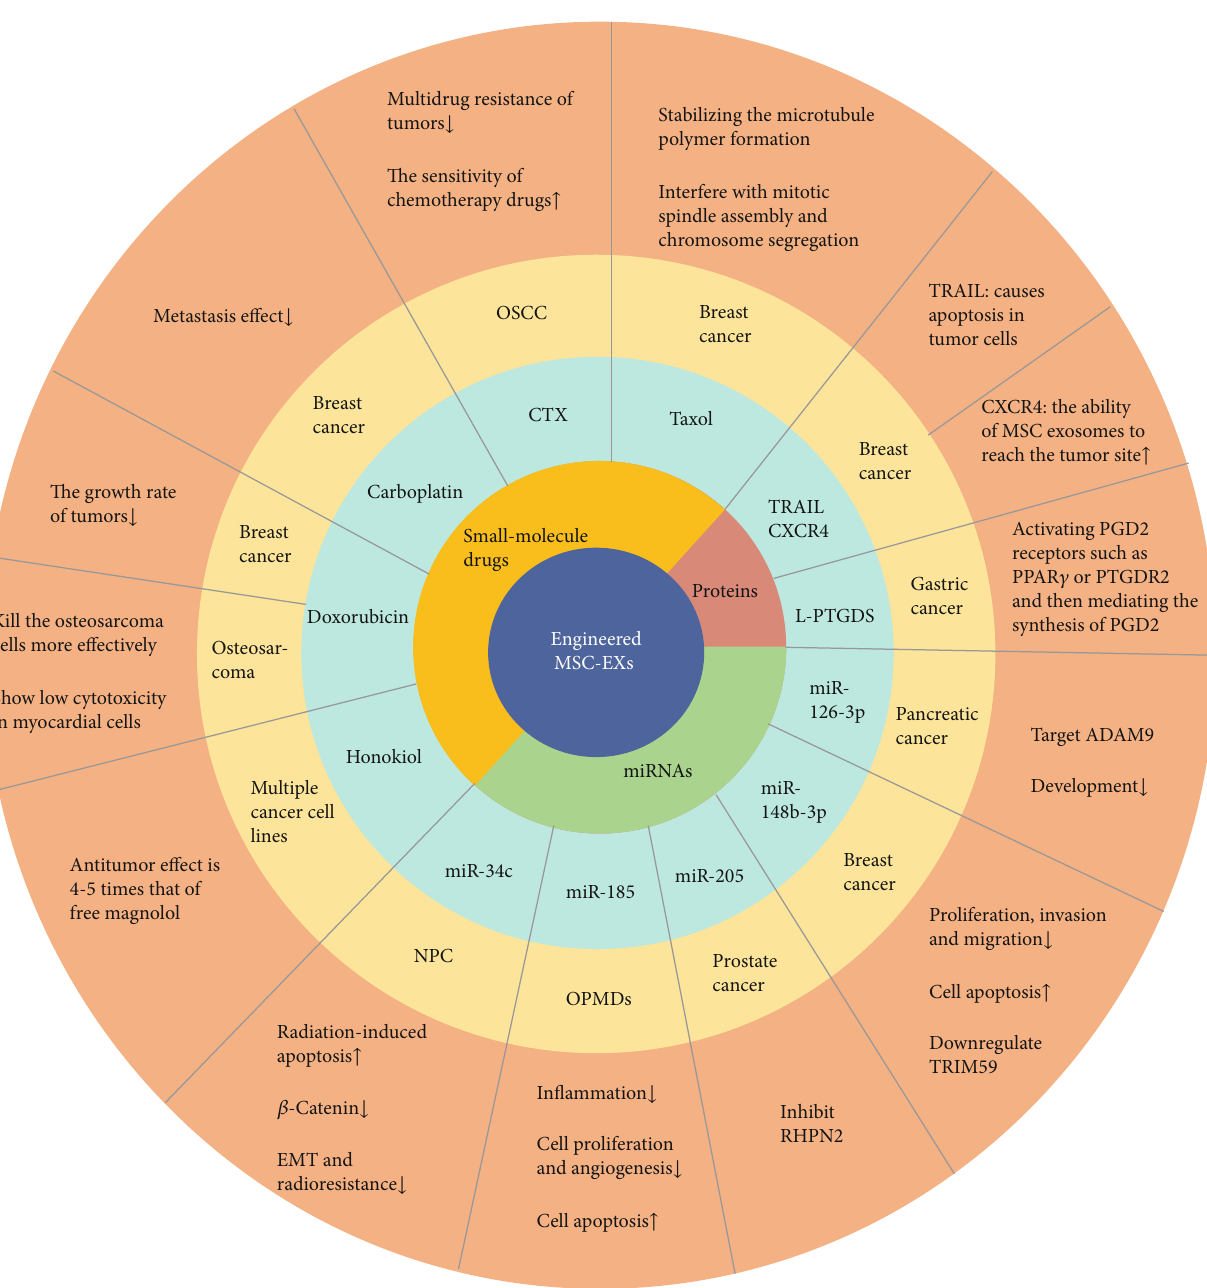
Figure 2: Engineered MSC-EXs for cancer treatment. The substances used for tumor treatment carried by the engineered MSC-EXs mainly include miRNAs, small-molecule drugs, and proteins. Four recent studies provide detailed information about miRNA loading in engineered MSC exosomes. Small-molecule drugs mainly include paclitaxel, CTX, carboplatin, doxorubicin, and magnolol. Compared with miRNAs and small-molecule drugs, few studies have reported the successful loading of proteins into